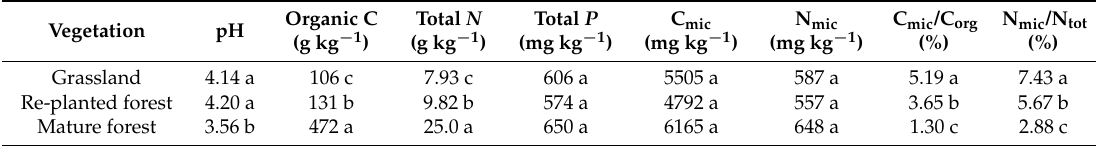
Table 1. Soil chemical properties and microbial biomass characteristics in the three vegetation zones. Vegetation